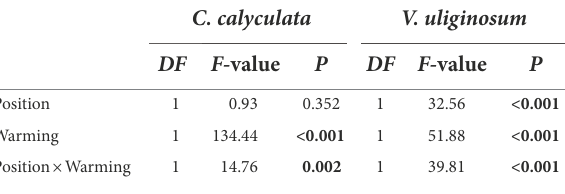
TABLE 2 A repeated measures analysis of variance shows the effects of climate warming and litter location and the interactions between them on the CO 2 emission rates from the different plant litter ( C. calyculata and V. uliginosum